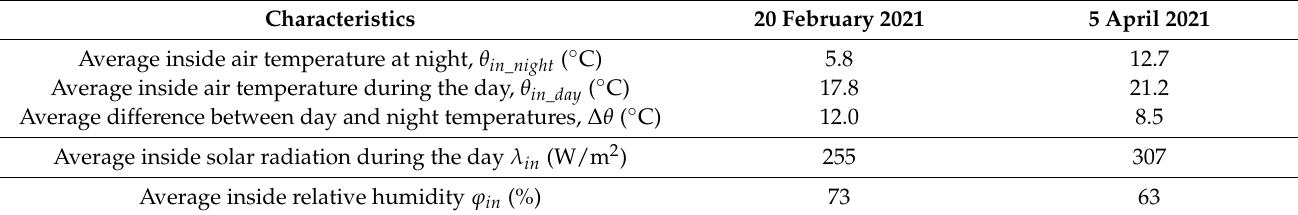
Table 6. Comparison of climatic parameters on different